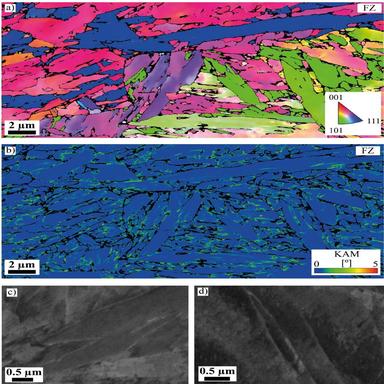
EBSD maps and AsB images of the fusion zone a) IPF map, b) KAM map, c, d) BSE images of sub-grain (lath) boundaries.